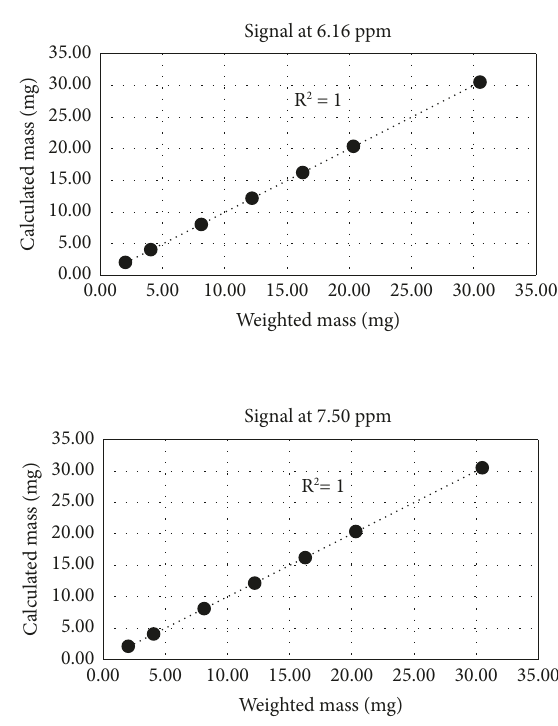
Figure 2: Response linearity of quantitation of 5-hydroxymethyl- 2(5H)-furanone using 1 H NMR. Aldehydic proton of vanillin. Ethylenic protons of